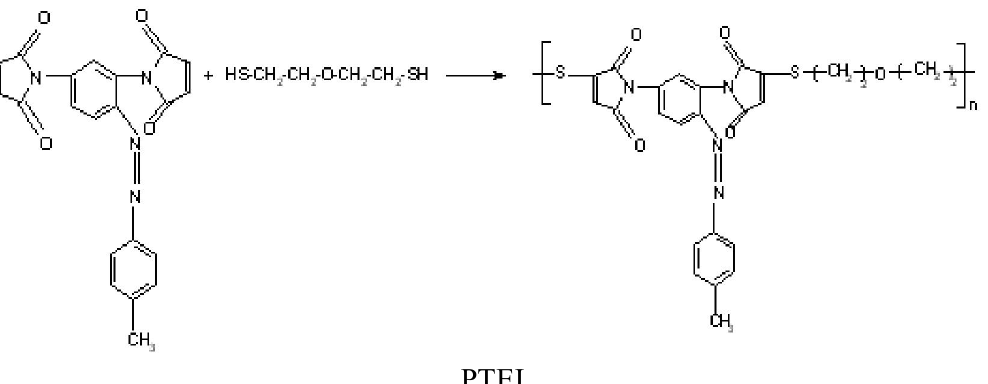
Scheme 2. Chemical structure of the studied